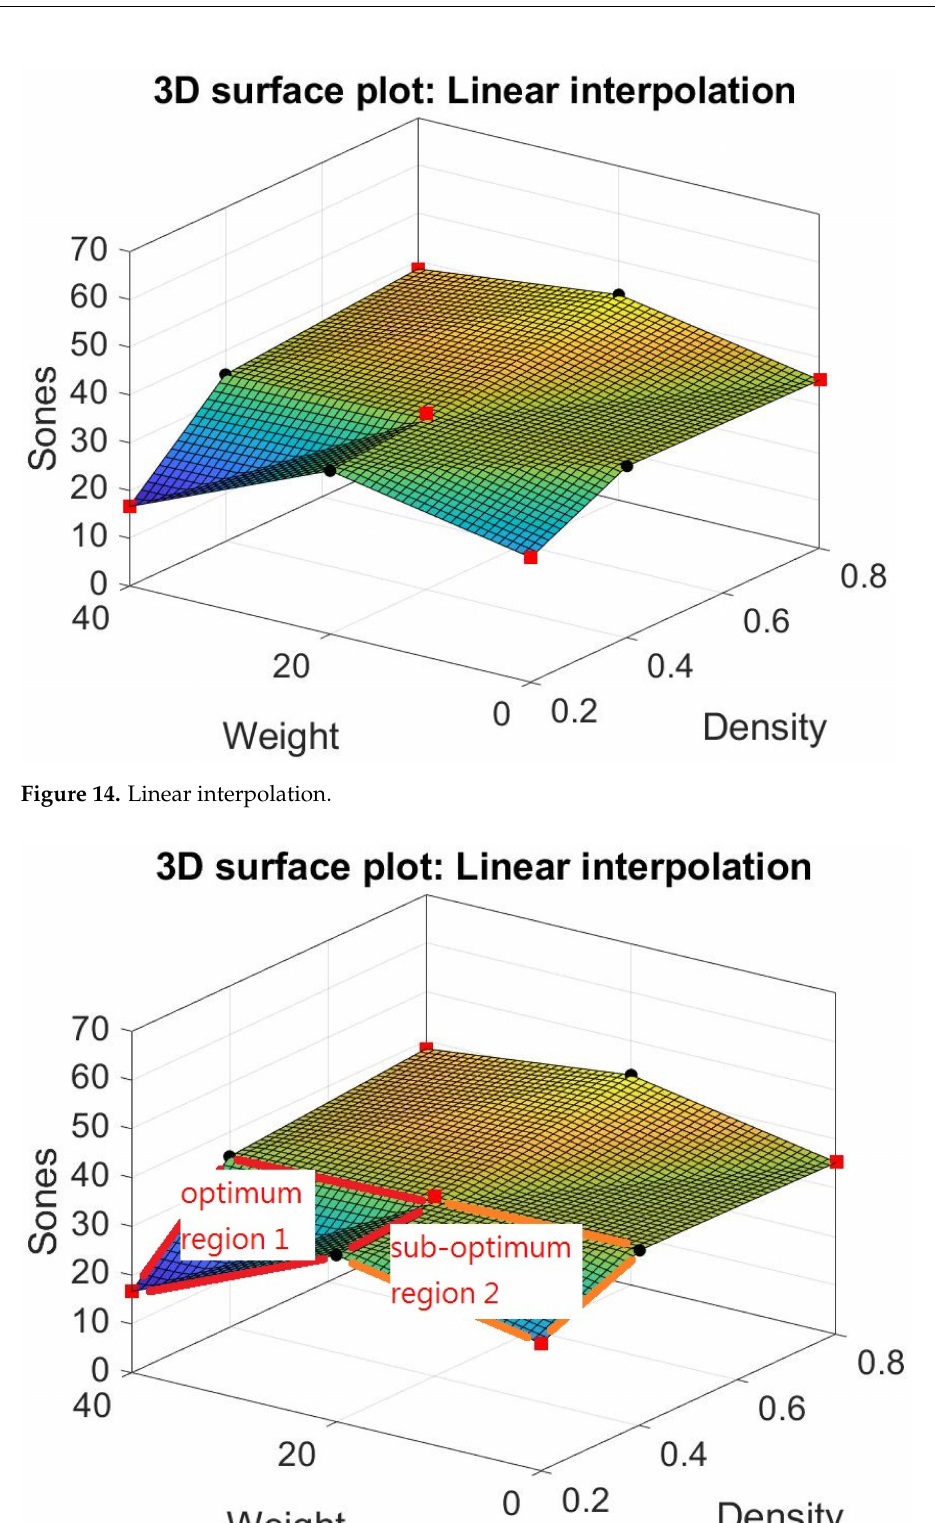
response surface to find its local minimum points. On the other hand, in the sub-optimum weight is 10 g, and density is 0.3 g/cm 3